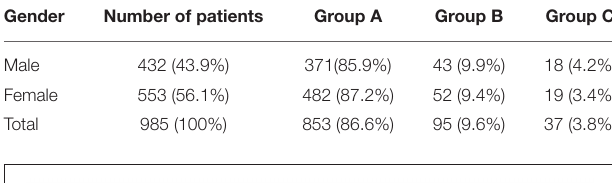
TABLE 1 | Distribution of patients by the time manifestation of PERH and biological sex.